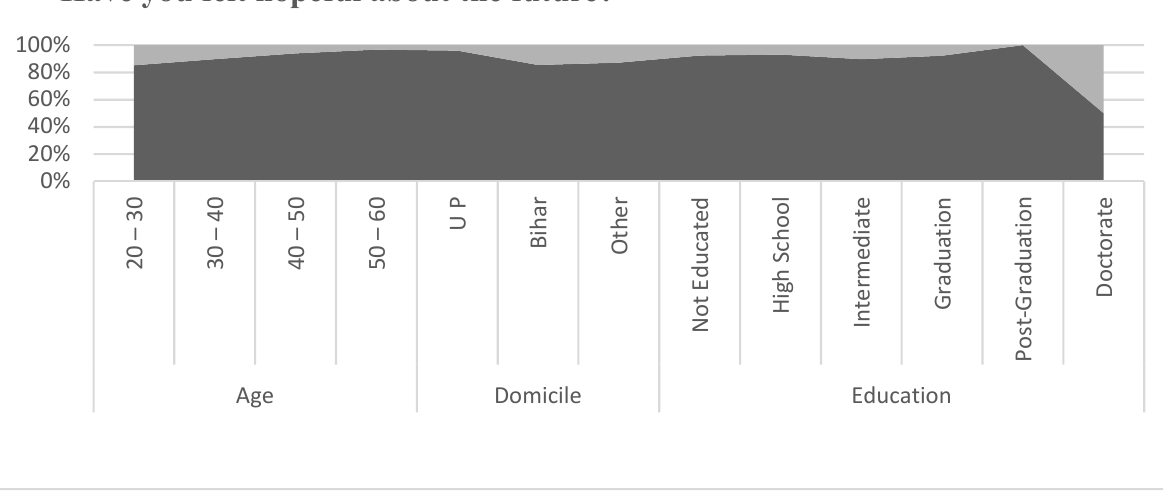
Figure 6. Comparison of feeling hopeful about future.